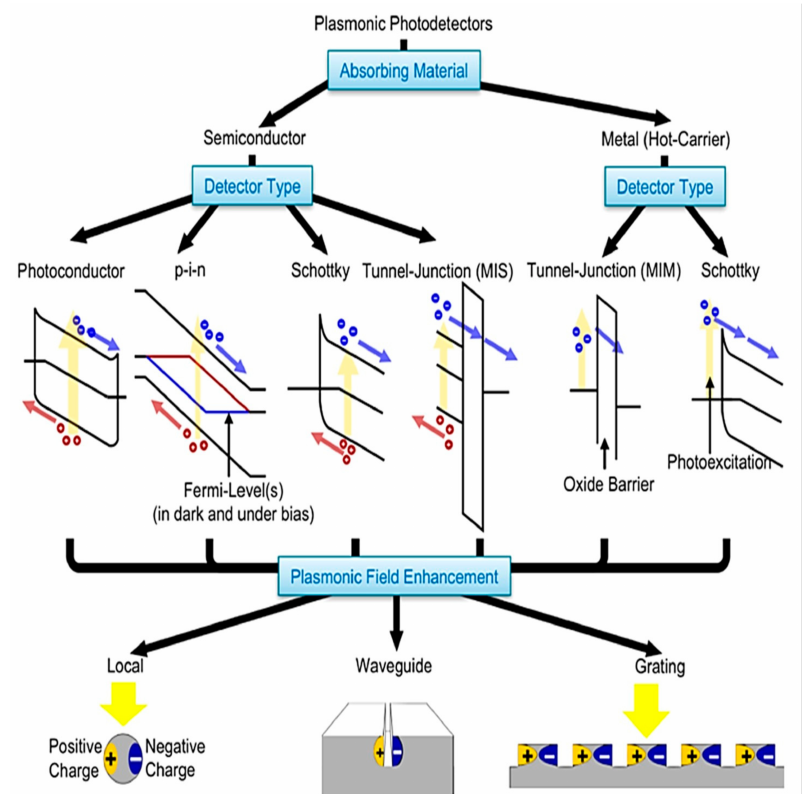
Figure 12. Simplified classification diagram of plasmonic photodetector (© 2018 IEEE. Reprinted, with permission, from